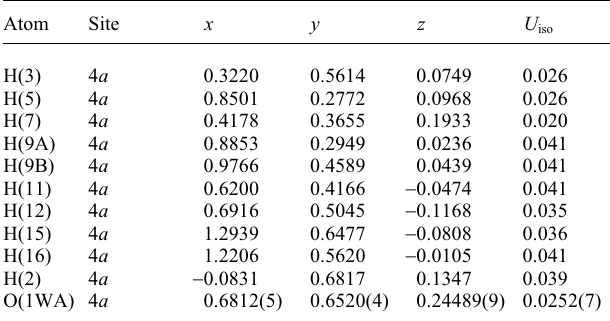
Table 2. Atomic coordinates and displacement parameters (in Å 2 ) .